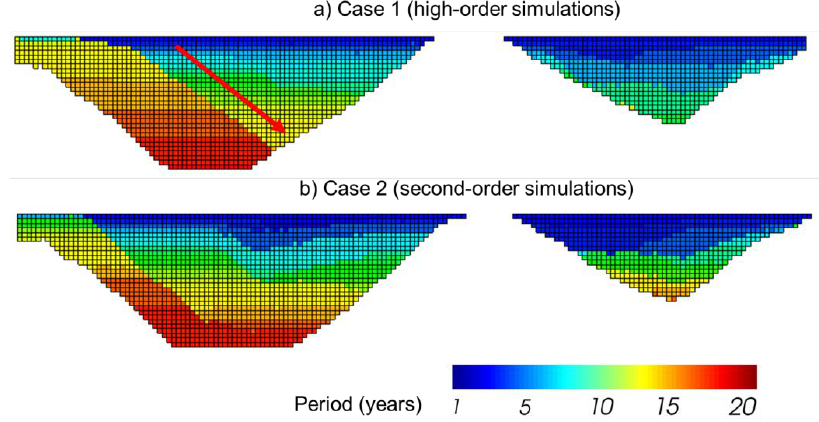
Figure 7. Cross-section of the LOM production schedule (plane North–South) obtained in ( a ) Case 1 and ( b ) Case 2. The red arrows show the preferential mining direction in the direction of higher continuity of high-grades.